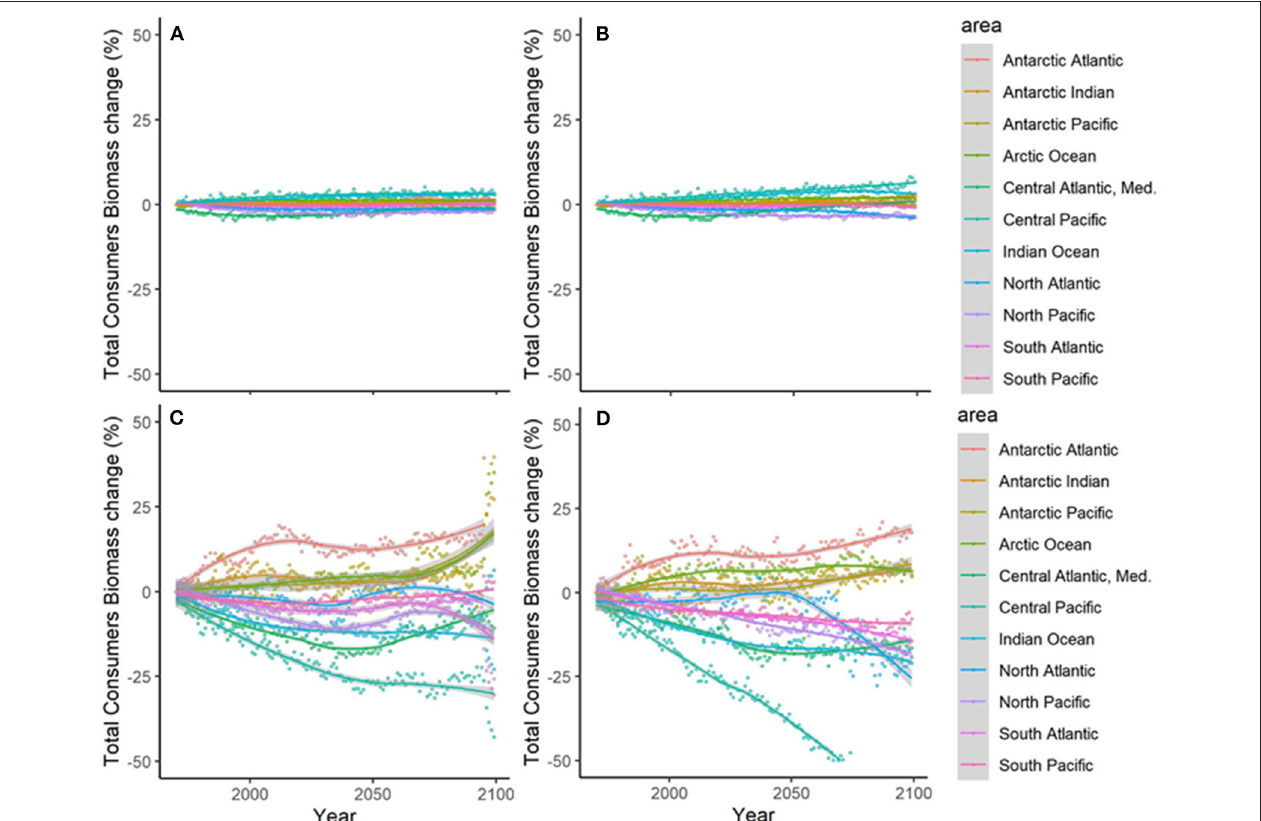
FIGURE 10 | Experiment 3 (Climate impacts and fishing impacts, Table 1 )—Relative temporal change of Total Consumers Biomass (%) by sub-regional oceans: (A) GFDL RCP2.6; (B) GFDL RCP8.5, (C) IPSL RCP2.6, and (D) IPSL